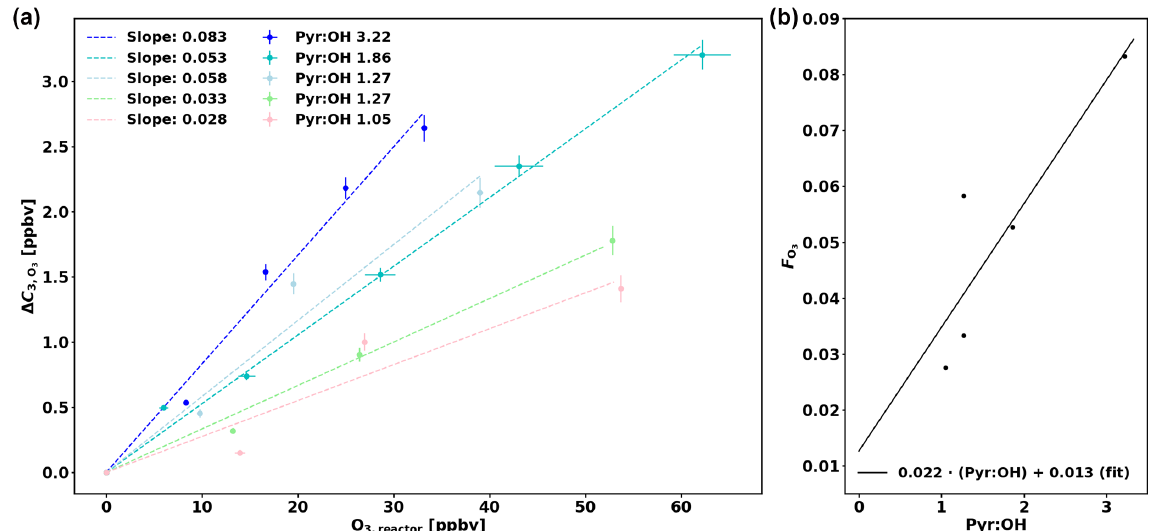
) as a function of ozone in the reactor (O 3 , reactor ). (b) O 3 correction factor ( F O 3